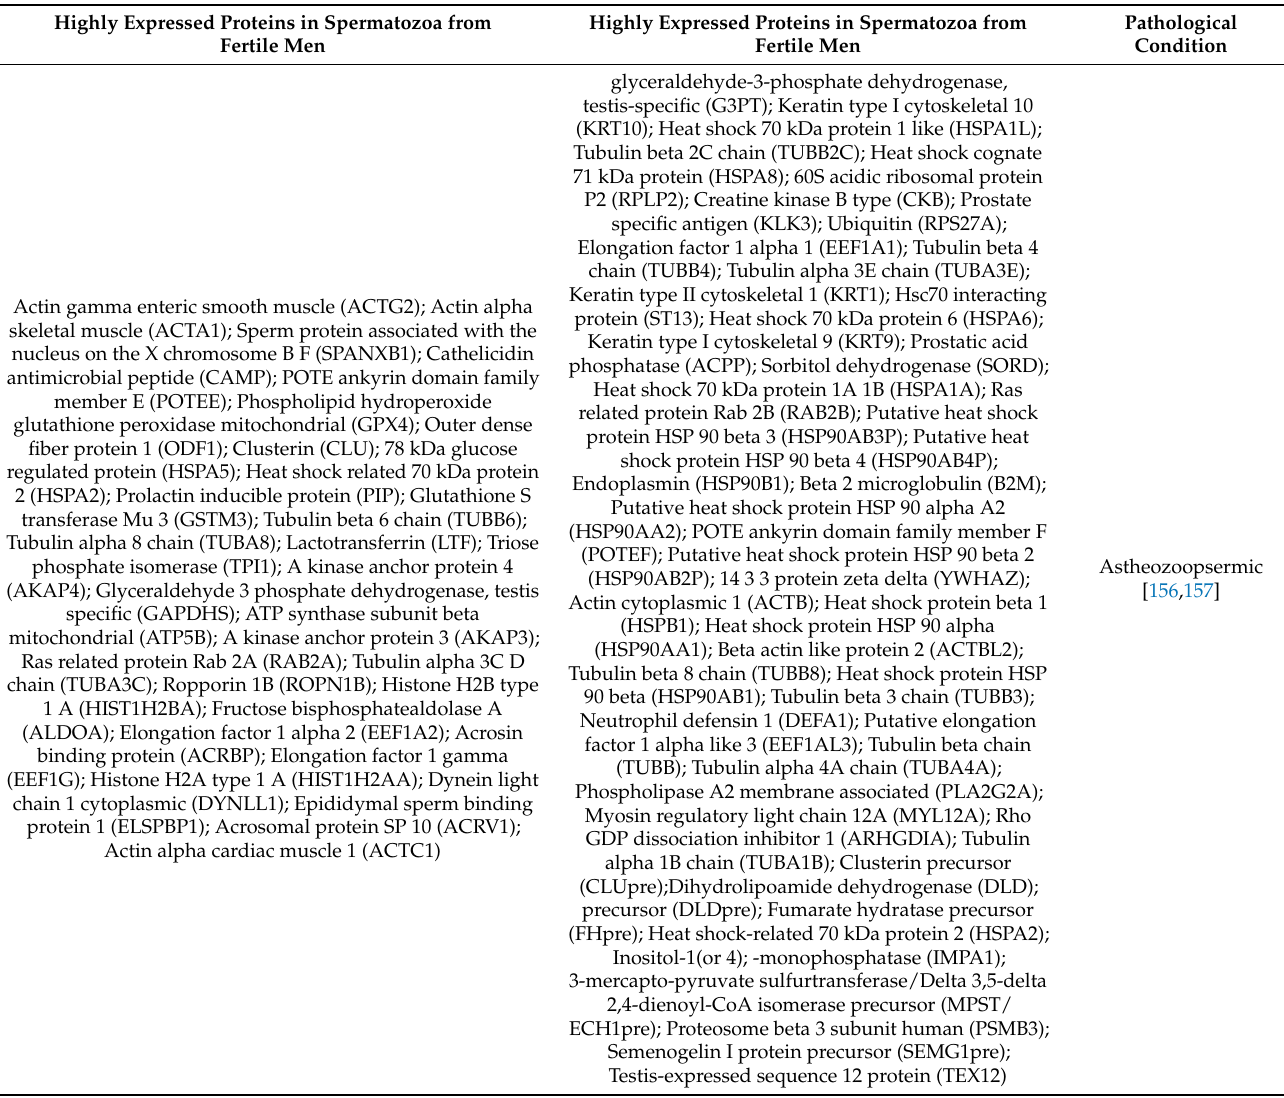
Table 3. Cont. Highly Expressed Proteins in Spermatozoa from Fertile Men